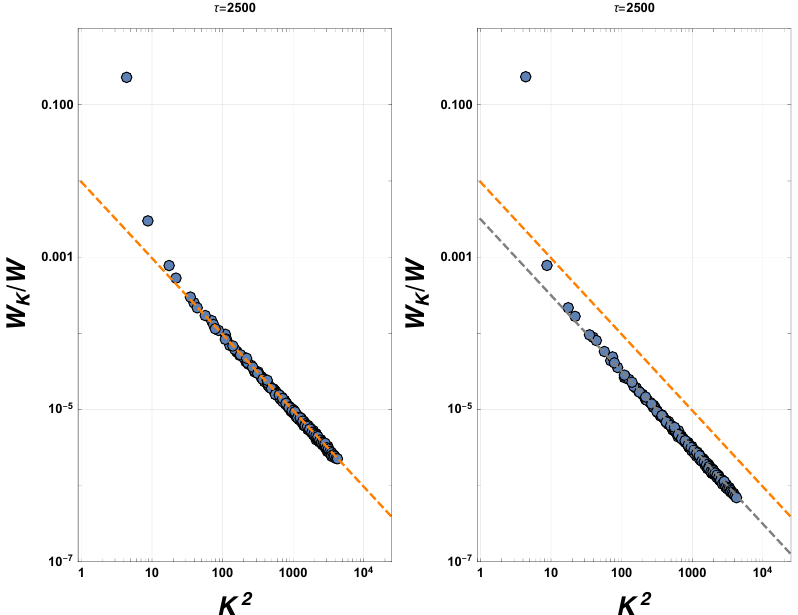
Figure 11. Case B. Left-hand panel: inviscid case. Right-hand panel: viscous case. Behavior of the time averaged W K / W for τ = 2500 (the orange dashed line denotes the line ∼ 1/ K 2 for the non viscous regimes and the gray one is the viscous counterpart.